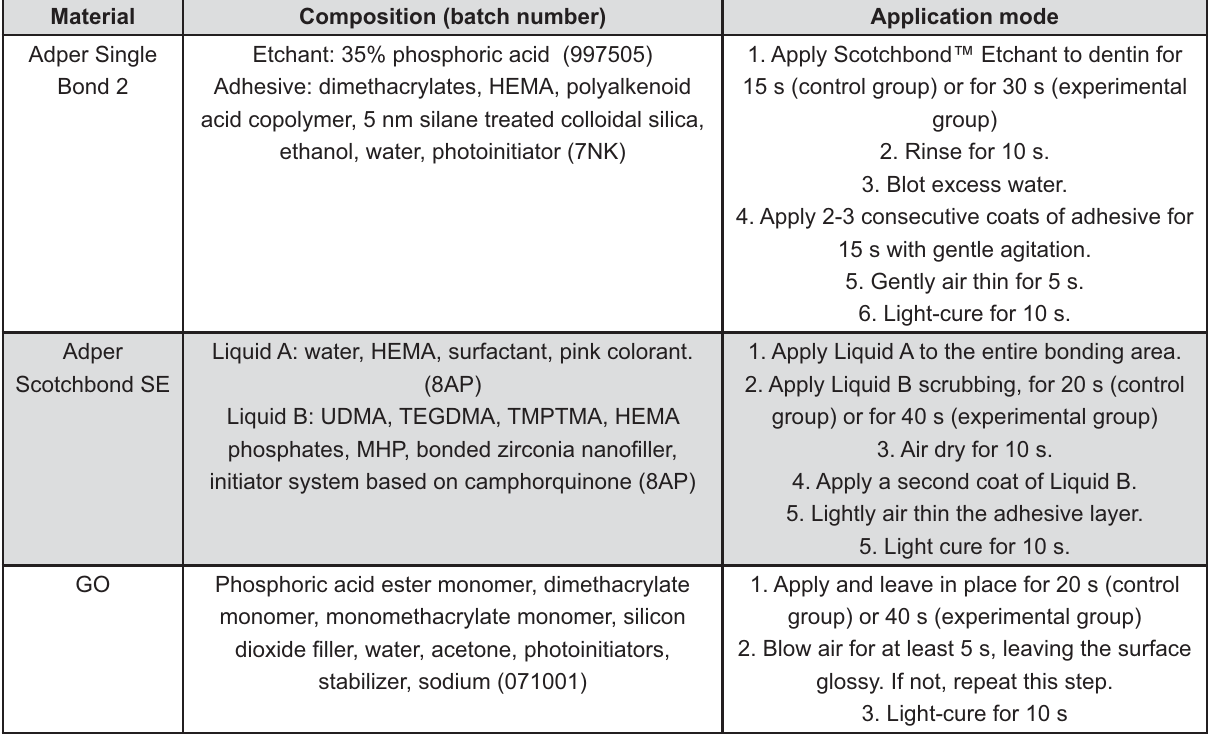
Figure 2- Composition (batch number) and application mode of the materials used in this